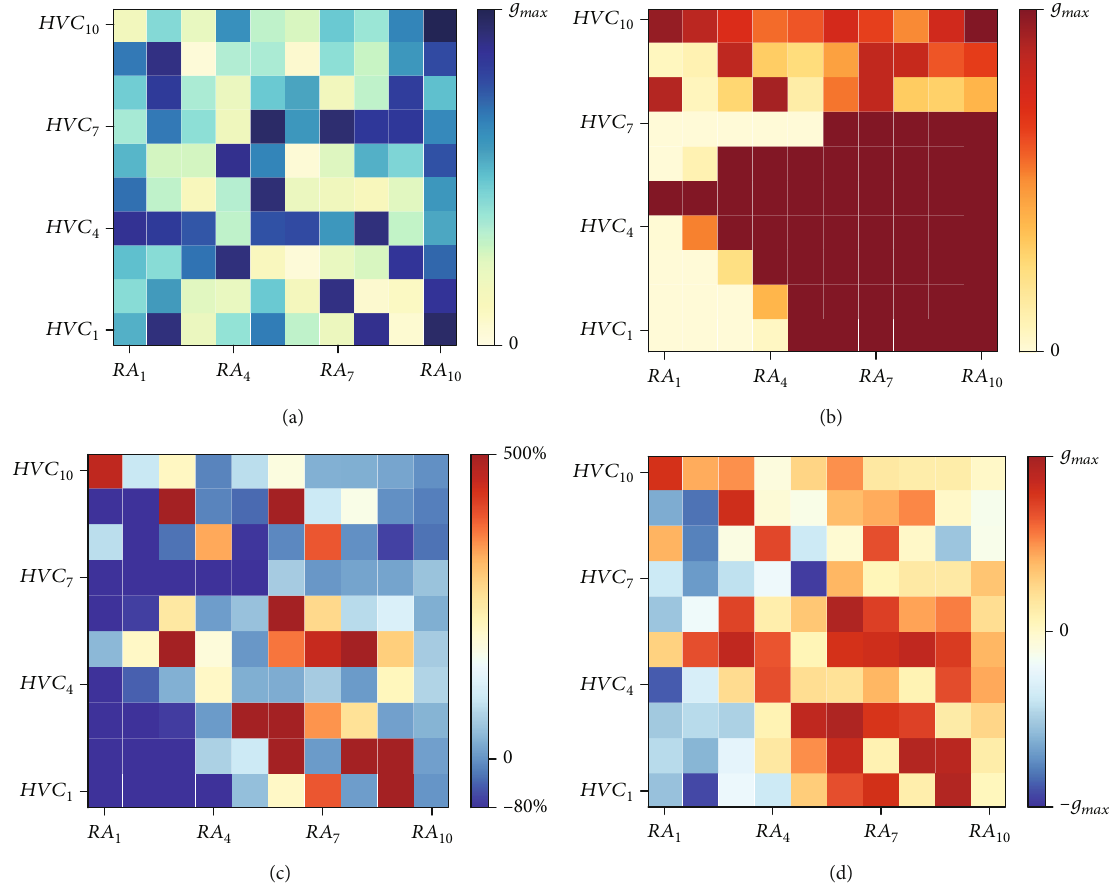
Figure 10: Synaptic conductance matrix and its adjustment caused by AFP during song learning. (a) and (b) show synaptic conductance matrices before and after training with color depth representing conductance intensity. (c) and (d) show adjustment rate and adjustment neuron and each RA neuron after training. In each subgraph, the square in ( i , j ) amount of synaptic conductance between each HVC RA represents the synaptic conductance from HVC to RA with its color indicating the value. i j